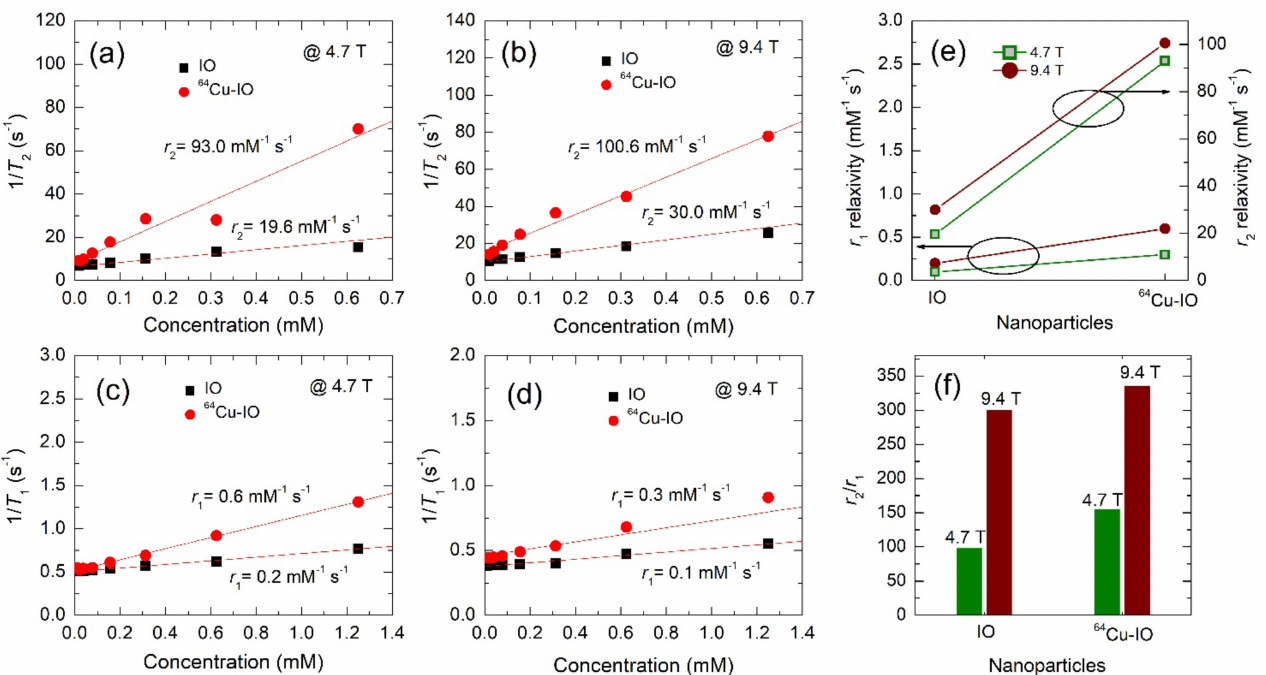
Figure 4. Transverse ( r 2 ) relaxivity of IO and chelator-free 64 Cu-IO NPs at ( a ) 4.7 T and ( b ) 9.4 T. Longitudinal ( r 1 ) relaxivity of IO and 64 Cu-IO NPs at ( c ) 4.7 T and ( d ) 9.4 T. ( e ) The r 1 and r 2 relaxivities at 4.7 T and 9.4 T for IO and 64 Cu-IO. ( f ) The r 2 / r 1 ratios for IO and 64 Cu-IO are compared at 4.7 T and 9.4